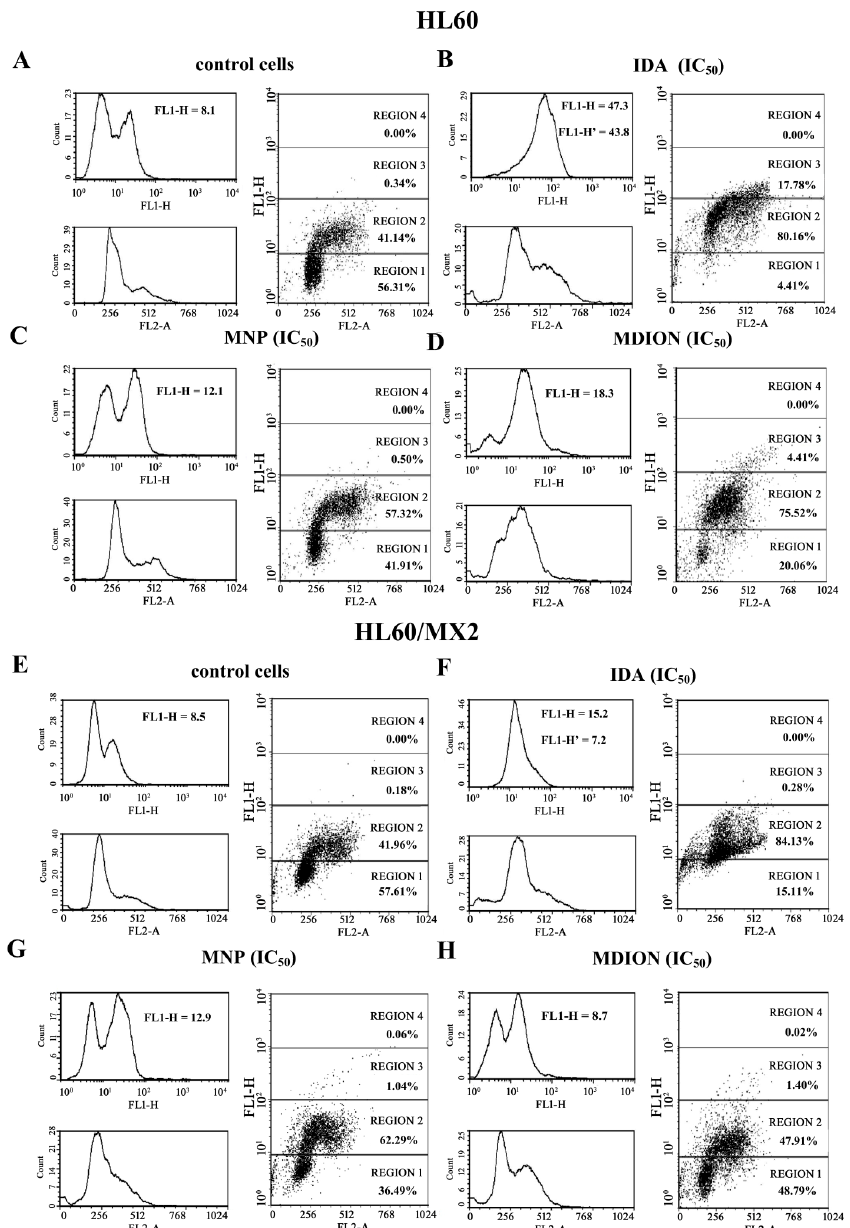
Figure 6. Level of the phosphorylated form of γ -H2AX in sensitive HL60 cells ( A – D ) and resistant HL60/MX2 ( E – H ) leukaemia cells treated with idarubicin (IDA; positive control), MNP, and MDION. The cells were incubated at 37 °C with studied compounds used at IC 50 (in the case of IDA, at 9.5 µM for HL60 cells and at 19.0 µM for HL60/MX2 cells, in the case of MNP, at 24.3 µM for HL60 cells and at 20.5 µM for HL60/MX2 cells, in the case of MDION, at 80.5 µM for HL60 cells and at 95.5 µM for HL60/MX2 cells) for 24 h. The experimental procedure for measuring the cellular level of the phosphorylated form of γ -H2AX is described in detail in the Materials and methods section. The green fluorescence FL1-H and red fluorescence FL2-A of 5 × 10 3 single events per sample were measured with the use of a laser beam at 530 ± 30 nm (λ ex = 488 nm) or 585 ± 21 nm (λ ex = 488 nm), respectively. The figure shows representative histograms and dot-plots obtained for control and treated cell samples in the presence of propidium iodide (PI) to determine the DNA content (FL2-A) and AlexaFluor 488-conjugated monoclonal antibody staining the phosphorylated form of histone γ -H2AX (FL1-H; FL1-H’ represent data obtained after subtracting the value corresponding to the IDA autofluorescence signal).